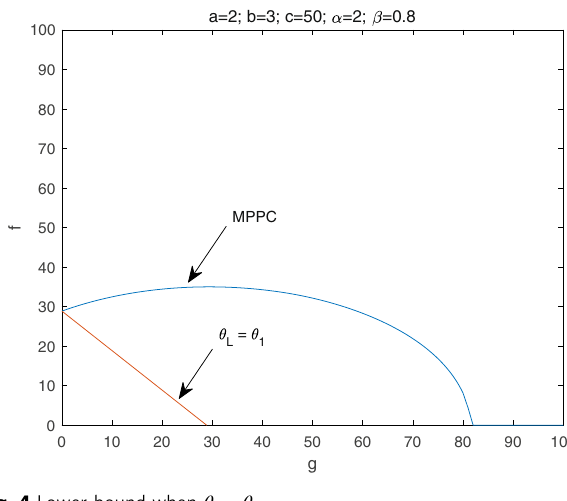
Fig. 3 Upper bound of aggregate endowments. Fig. 4 Lower bound when θ L = θ 1 .